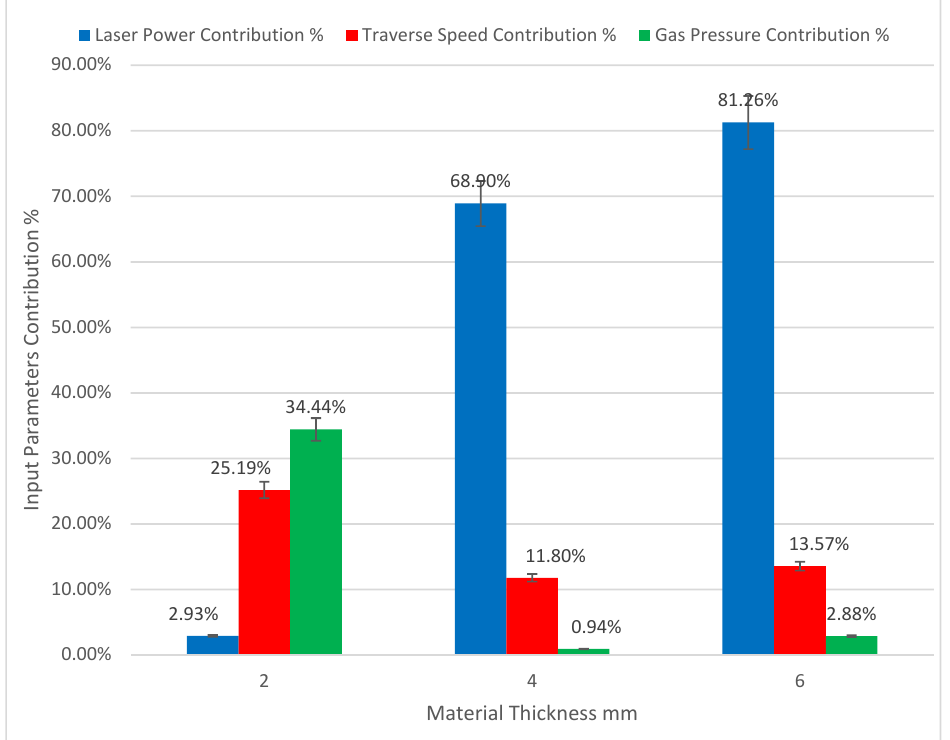
Figure 6. Input parameter contributions to kerf taper angle of the various material thicknesses of SPF-UPE composite cut with laser beam cutting technology.